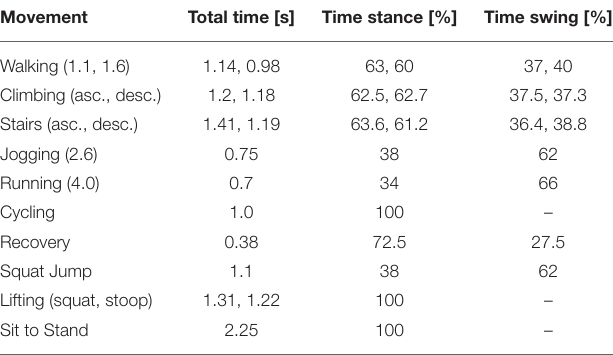
TABLE 4 | Time characteristics of the analyzed movements. Movement Total time [s] Time stance [%] Time swing [%] Walking (1.1, 1.6) 1.14, 0.98 63, 60 Climbing (asc.,